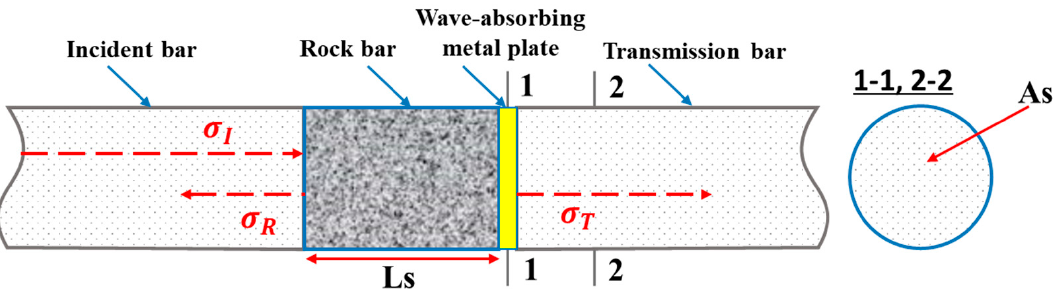
Figure 4. Stress-wave-propagation diagram.